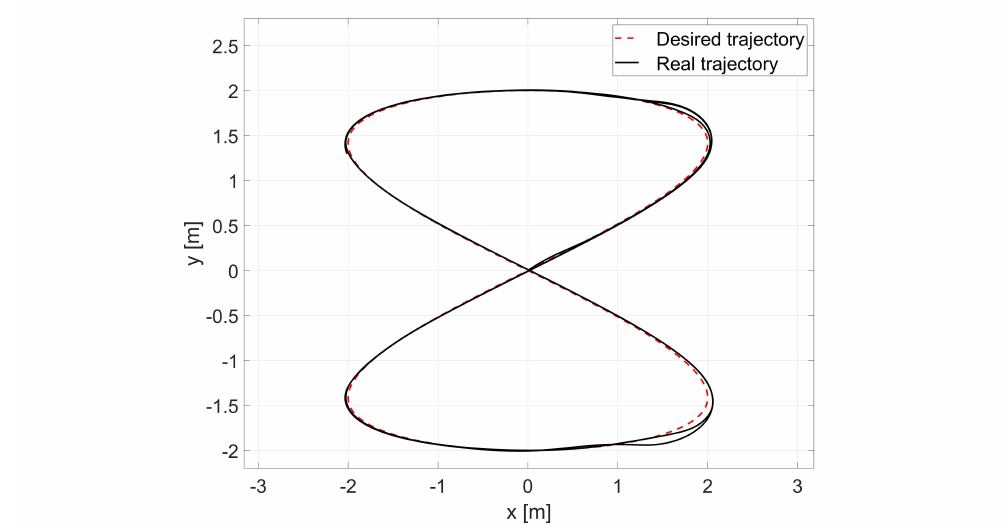
Figure 15. Comparison of reference and real trajectories in a laboratory